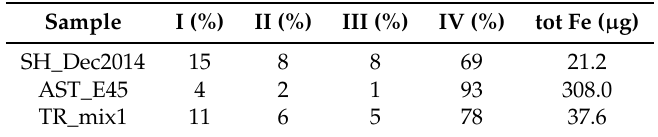
Table 4. Leaching test results on Saharan dust (SH_Dec2014), steel production emission (AST_E45) and mixed Saharan (TR_mix1)